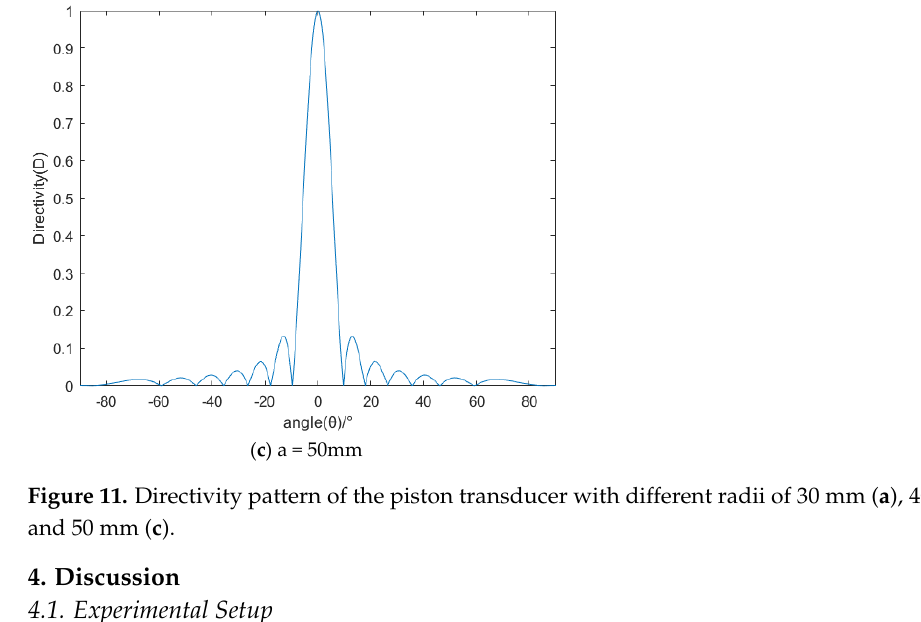
Figure 12. Experimental setup.